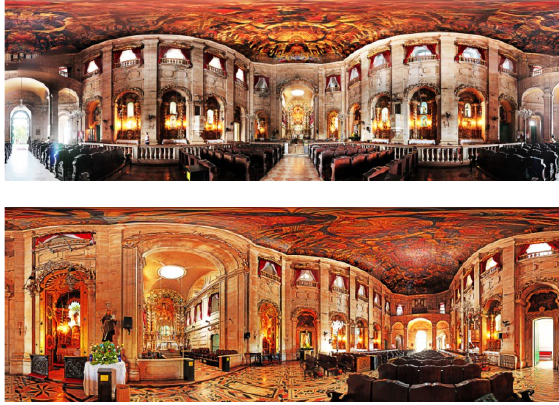
Figure 3. Examples of indoor spherical panoramas: Igreja de Nossa Senhora da Conceição da Praia,